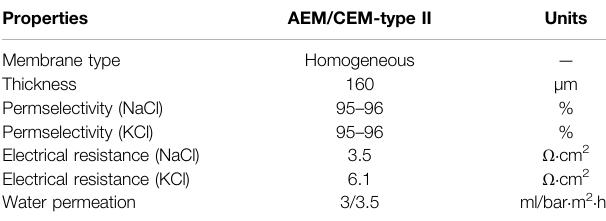
TABLE 3 | Properties of ion exchange membranes.